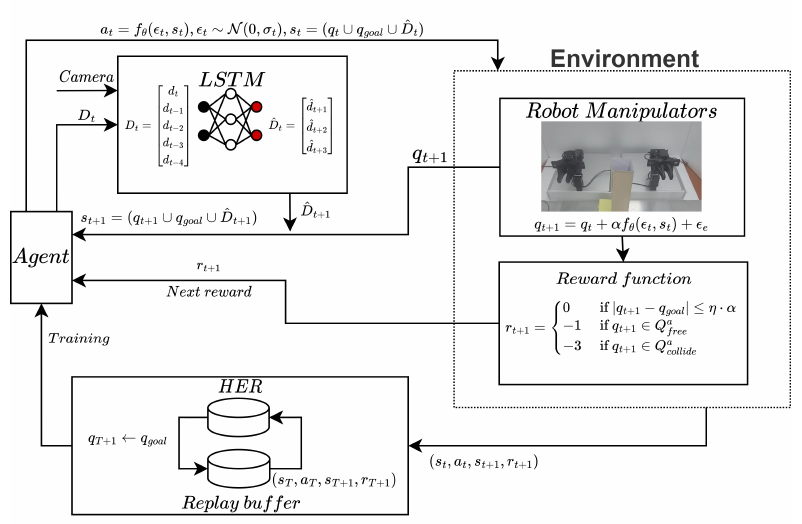
Figure 1. Multi -Arm Manipulator MDP with Position Estimation of Moving Obstacles via LSTM